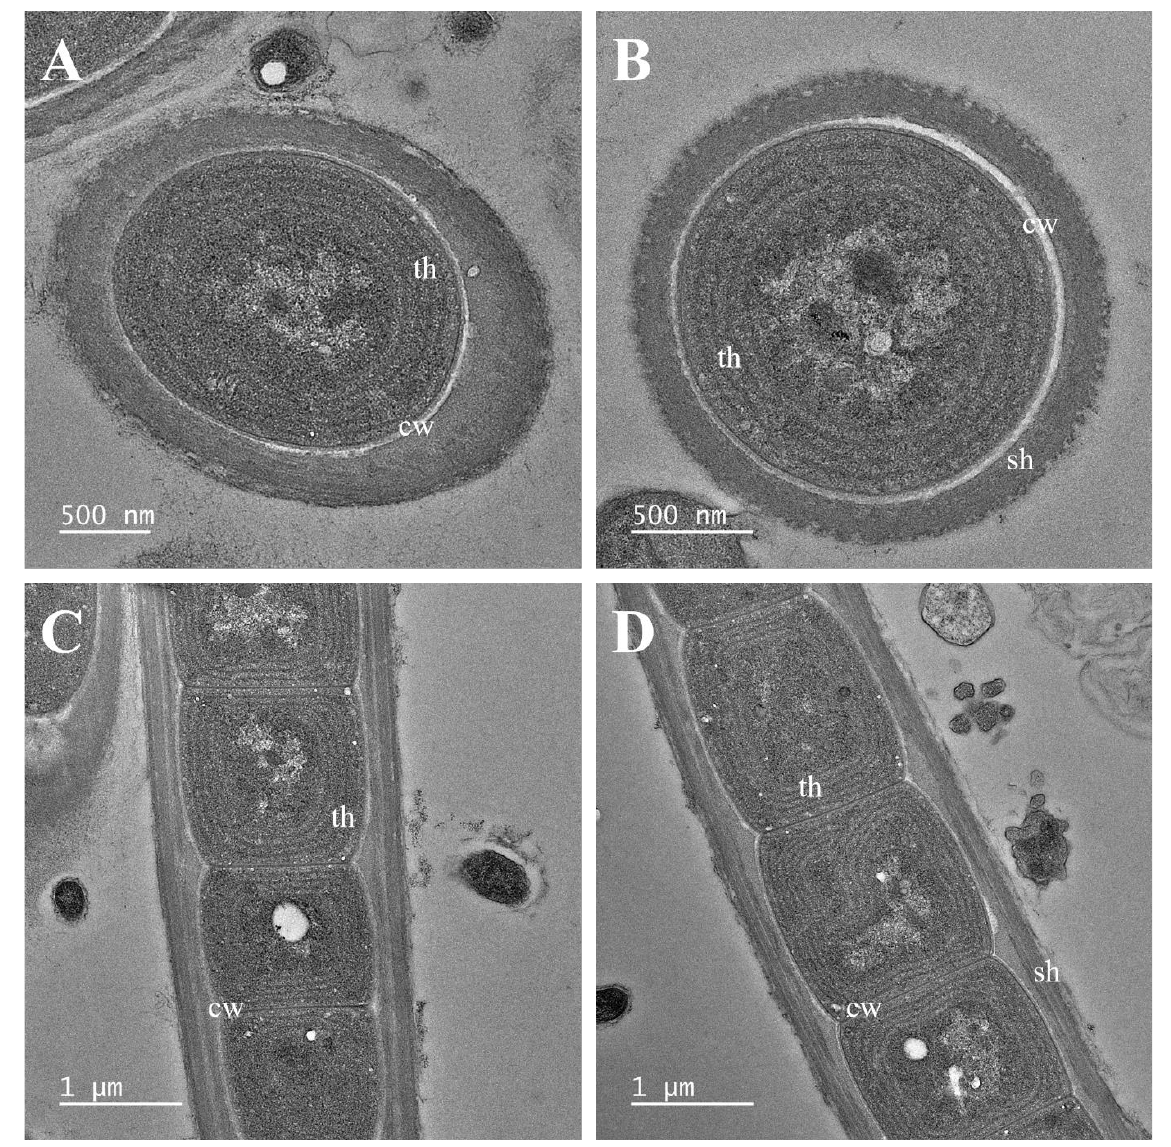
Figure 5. Transmission electron micrographs of Plectolyngbya koreana strain FBCC-A1478. ( A , B ) Pa- rietal thylakoids seen in cross section. ( C , D ) Parietal thylakoids appearing in the longitudinal